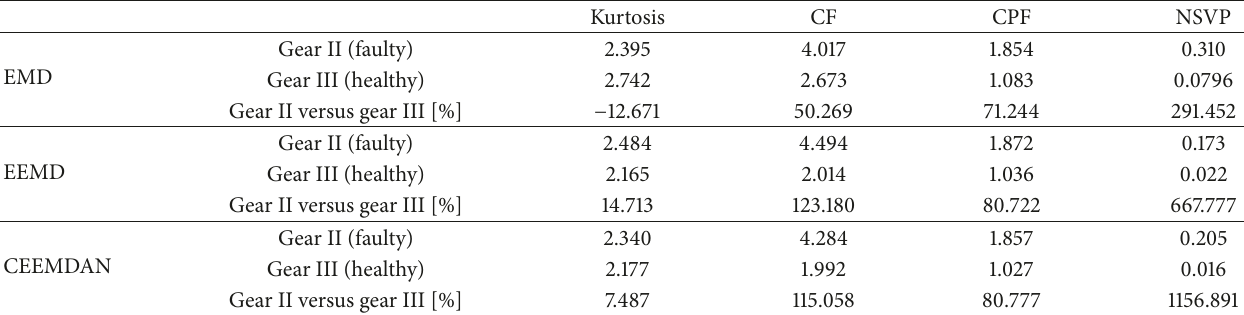
Table 2: CIs for the simulated signal with localized fault in gear